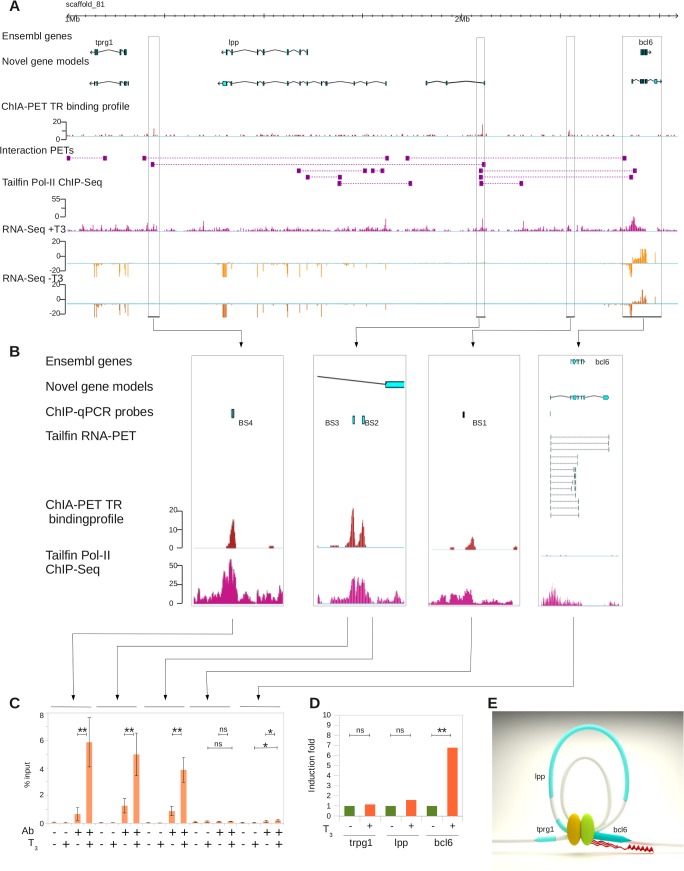
Benefit of genome re-annotation with RNA-PET for ChIA-PET analysis.A. Large genomic view of the bcl6 locus. Track order: Ensembl genes, RNA-PET-based models, ChIA-PET TR binding density, interaction PETs, RNA Pol-II binding density, RNA-Seq reads density with (+T3) and without (-T3) treatment with thyroid hormones. B. Close up on TR binding sites. Track order: Ensembl genes, RNA-PET-based genes, location of ChIP-qPCR probes, RNA-PET ditags, TR binding density and RNA Pol-II binding density. C: ChIP-qPCR validation of TR binding at locations shown in B. Ab: Antibody, T3: 3’,5,3’ triiodothyronine treatment. D: Induction of trpg1, lpp and bcl6 genes transcription assayed by RT-qPCR. E: Three-dimensional model of the locus topology.